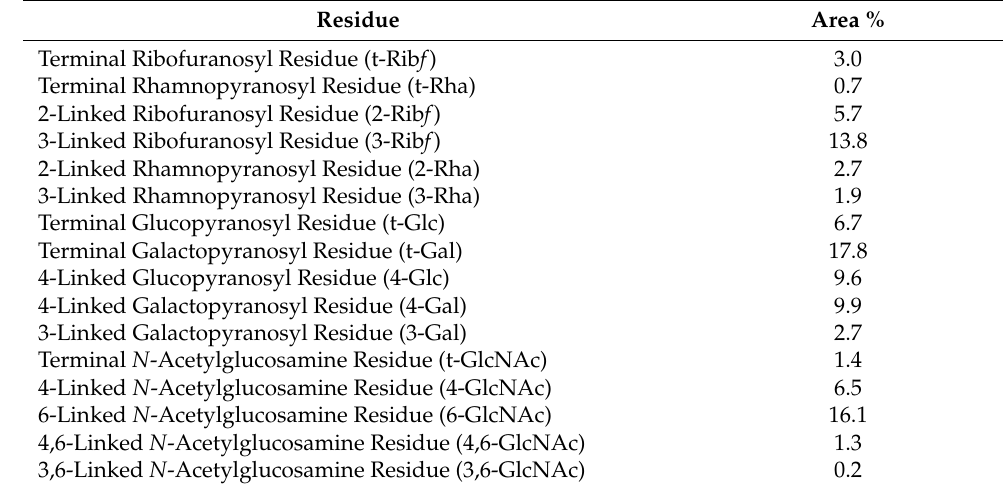
Figure 5. Results of the linkage analysis of the Lcr LPS. Linkage analysis was obtained on the LPS by preparation of partially methylated alditol acetates (PMAA). Asterisks mark unknown non-carbohydrate peaks. The chromatogram also shows the presence of contaminating lipid A (i.e., the presence of 6-linked GlcN) in the sample. Table 3. Partially methylated alditol acetates generated from the Lcr LPS.